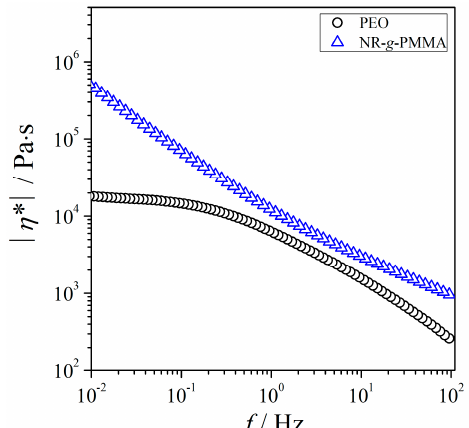
Figure 2. Plots of complex viscosity as a function of frequency for PEO and NR- g -PMMA at T = 140 ◦ C. The results for PEO are indicated by circles; the results for NR- g -PMMA are indicated by triangles.